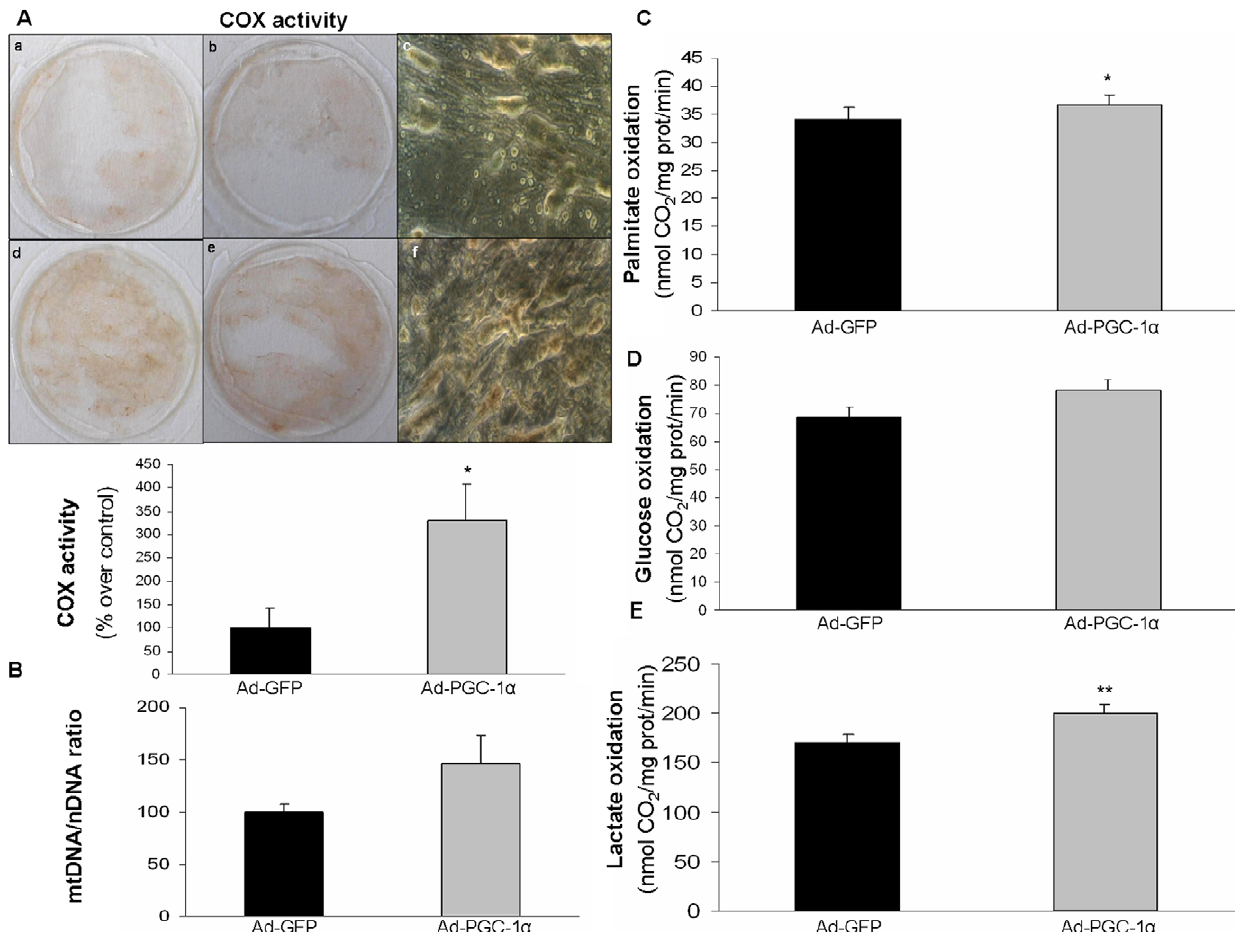
Figure 4. Effect of PGC-1 a -overexpression on mitochondrial COX activity, mitochondrial to nuclear DNA ratio and oxidation of metabolic substrates in cultured muscle cells. Cultured muscle cells were transduced with Ad-GFP or Ad-PGC-1 a adenoviruses. (A) Cytochemical staining of COX activity was performed in cultured skm cells that had been transduced with Ad-GFP (a, b and c) or Ad-PGC-1 a (d, e and f). Images were obtained with a camera (a,b,d,e) or with an inverted microscope at 800 6 magnification (c,f). Images from two independent experiments performed in duplicate were quantitatively analyzed and the data expressed as percentages of the values in the controls: means 6 SEM are shown on the graph. The significance of the difference is *p , 0.005. (B) Cells were harvested and total DNA isolated to measure the ratio of mitochondrial DNA (mtDNA) content to nuclear DNA (nDNA) content. Data are expressed as a percentage of control. Data are means 6 SEM from two experiments performed in triplicate. (C–E) Cells were then incubated for 4 h with: (C) 0.5 mM [1- 14 C]-palmitate (2.8 m Ci/ m mol), (D) 10 mM [U- 14 C]- glucose (0.21 m Ci/ m mol) and (E) 2 mM [U- 14 C]-lactate (0.6 m Ci/ m mol). Production of 14 CO 2 was subsequently quantified. Data are expressed as means 6 SEM from two experiments performed in sextuplicate. The significance of the difference is *p , 0.005 and **p ,